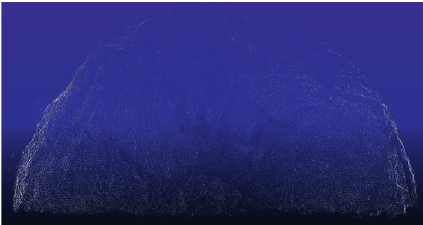
Figure 12: The point cloud extracted after dense reconstruction.